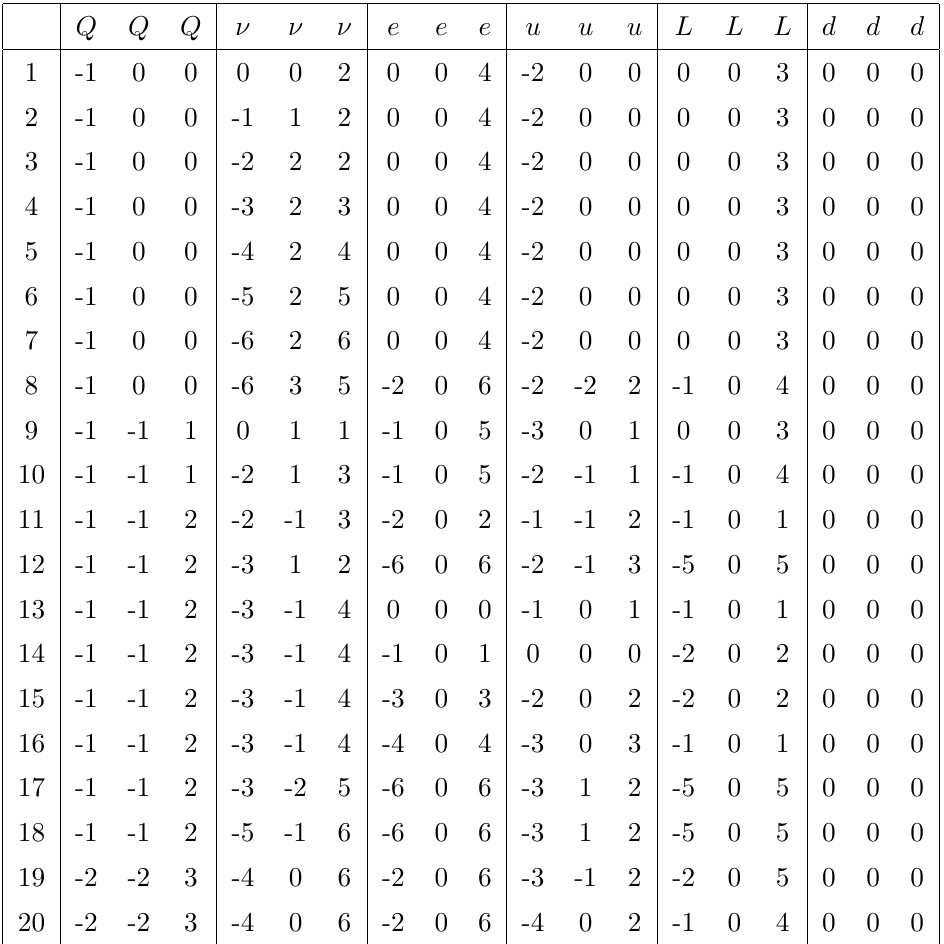
Table 5 . U(1) F charges output by the program for solutions satisfying Ellis, Fairbairn, and